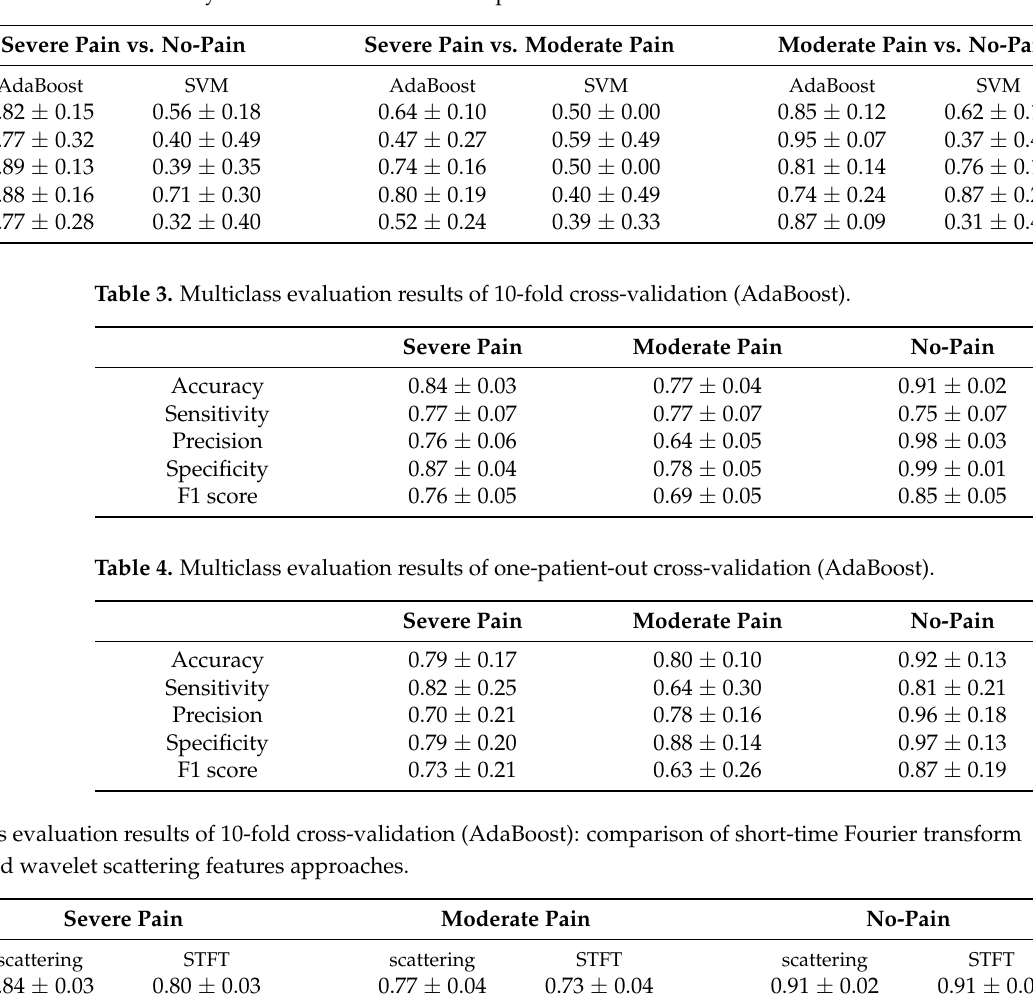
Table 2. Binary classification results of one-patient-out cross-validation.